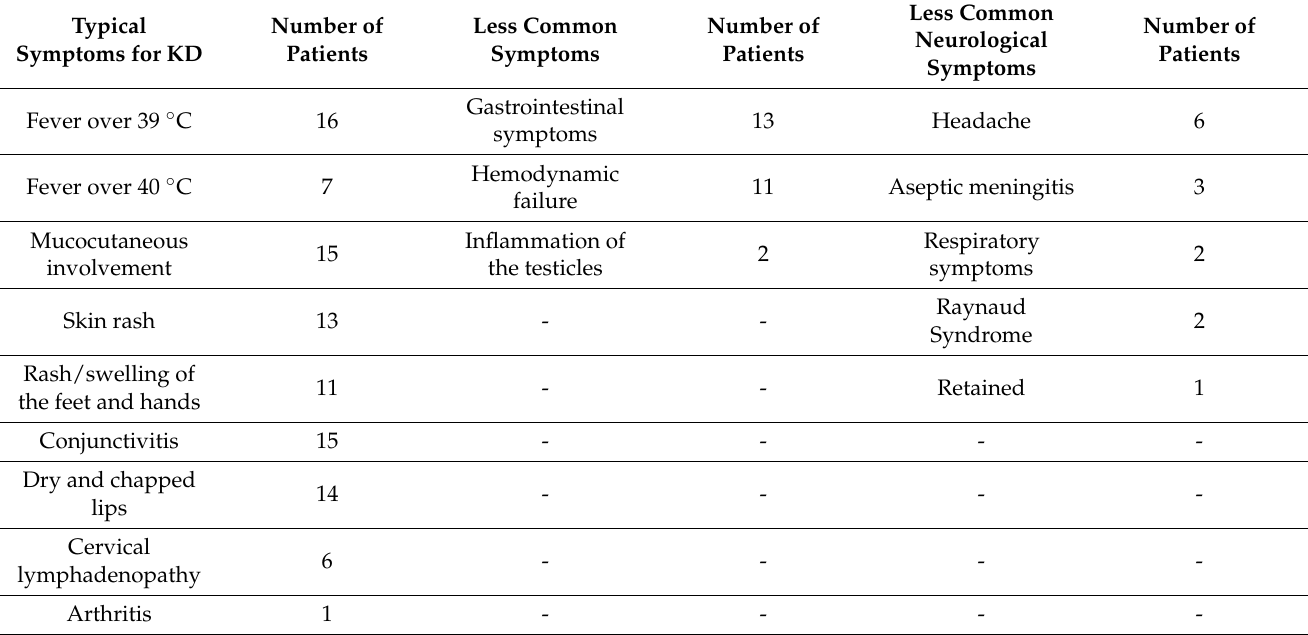
Table 1. The frequency of Kawa-COVID-19